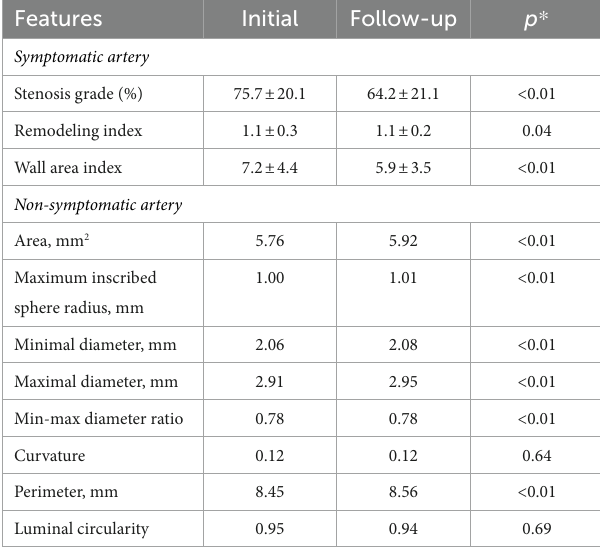
TABLE 2 Changes of the vessel wall features after 6 months of high-dose statin